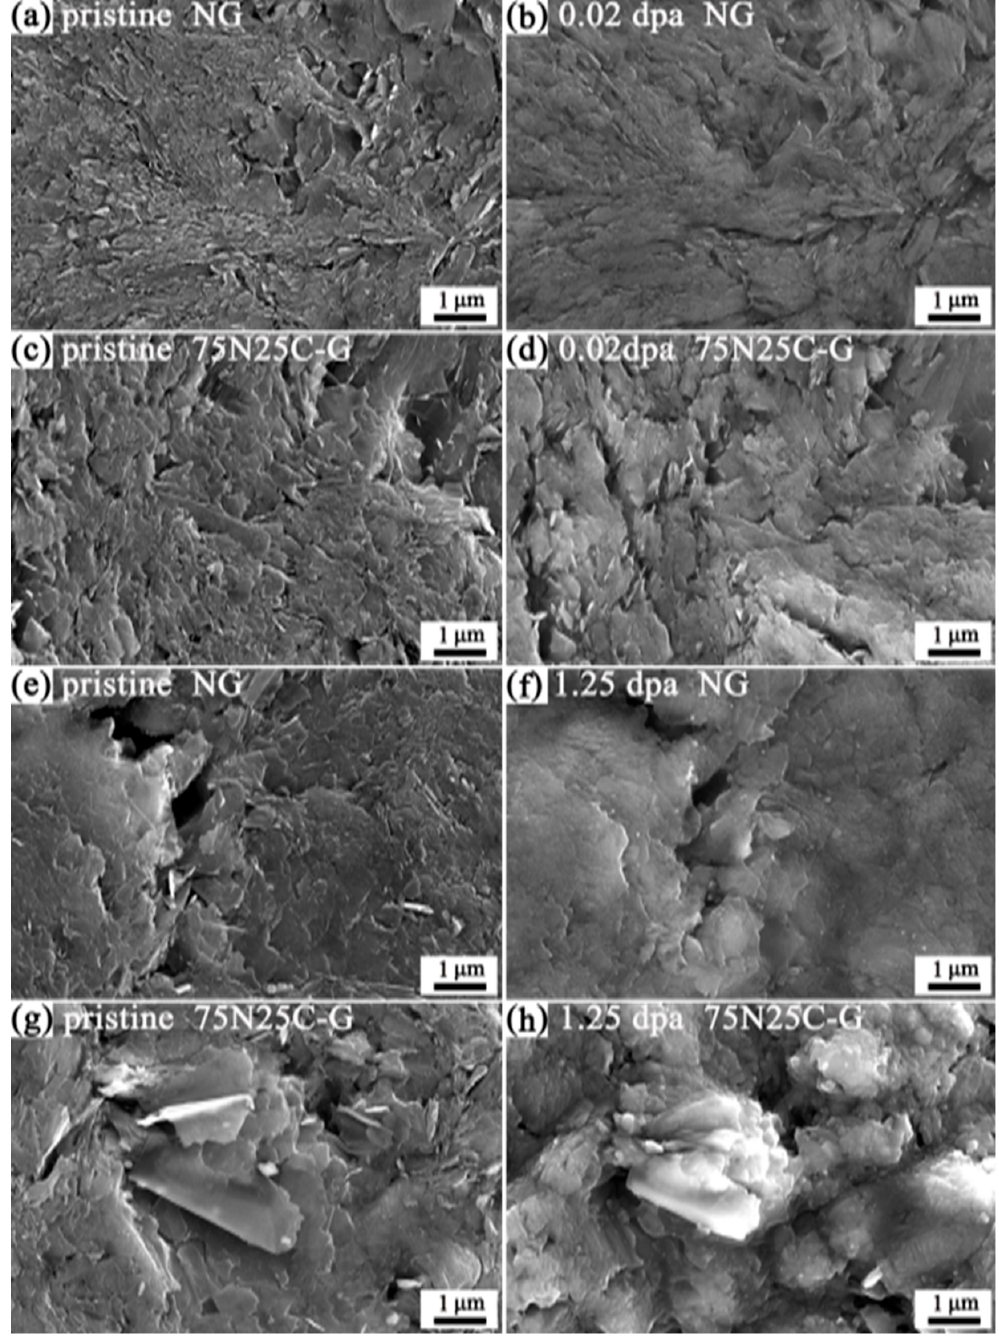
Figure 3. Magnified SEM images of NG and 75NG25C-G before and after irradiation at a surface damage dose of 0.02 dpa ( a – d ) and 1.25 dpa ( e – h ).